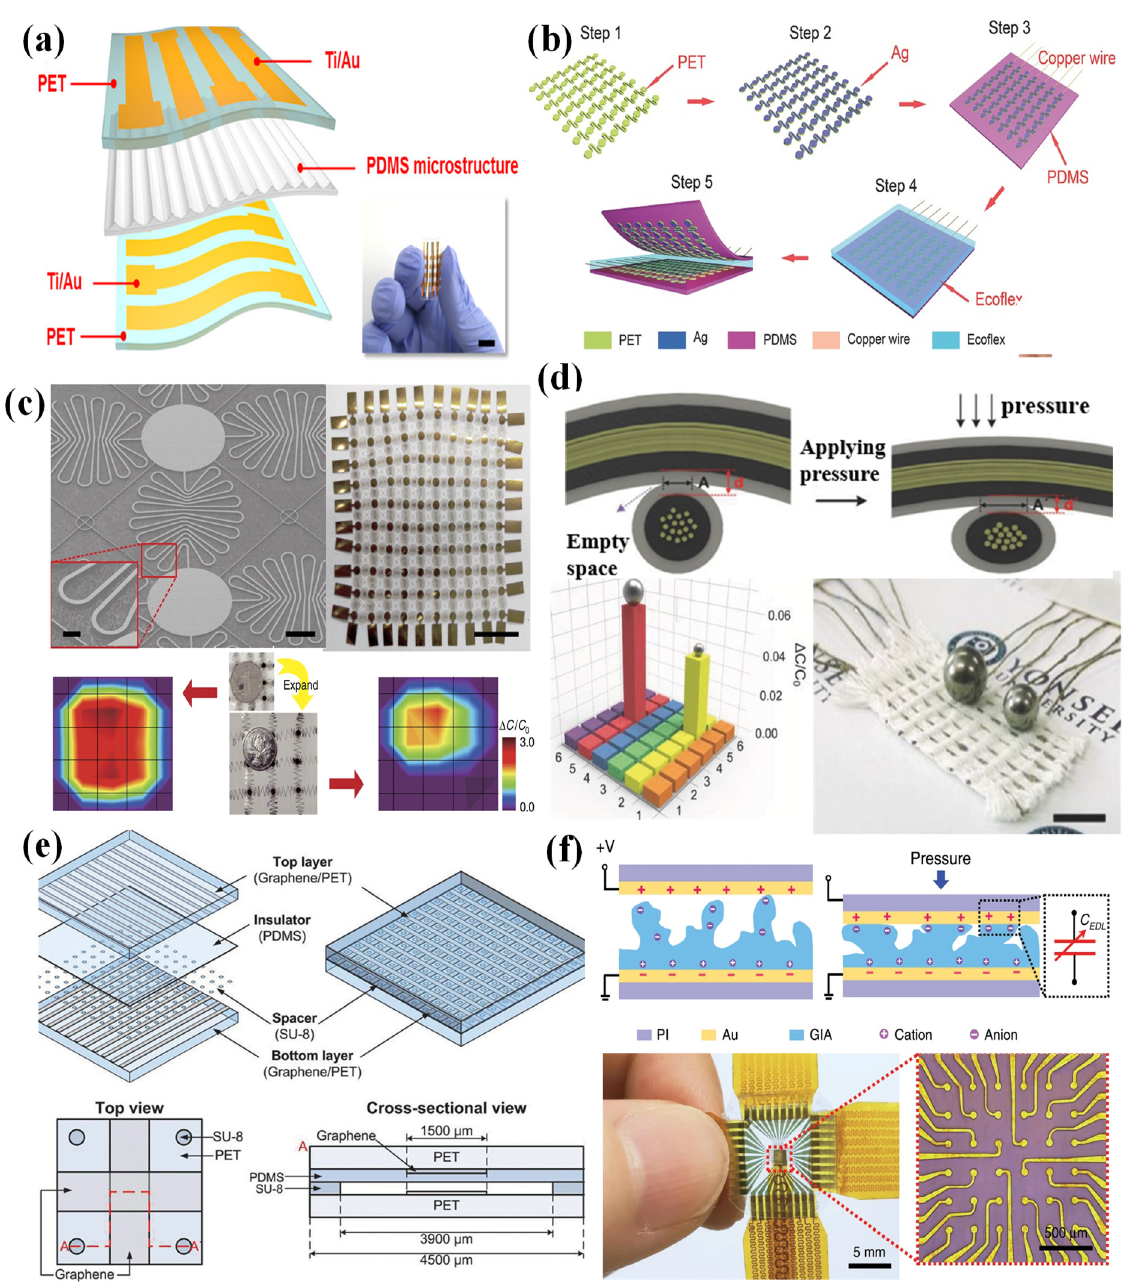
Figure 2. ( a ) A tunable, ultrasensitive, and flexible pressure sensor array based on wrinkled microstructures. Reproduced with permission from Ref. [71]. Copyright 2019, American Chemical Society. ( b ) A flexible, stretchable, and wearable multifunctional sensor array for static and dynamic strain mapping. Reproduced with permission from Ref. [72]. Copyright 2015, WILEY-VCH. ( c ) A skin-inspired highly stretchable and conformable matrix network for multifunctional sensing. Reproduced with permission from Ref. [73]. Copyright 2018, Qilin Hua et al. ( d ) A conductive fiber- based ultrasensitive textile pressure sensor. Reproduced with permission from Ref. [74]. Copyright 2015, WILEY-VCH. ( e ) A flexible, transparent, sensitive, and crosstalk-free capacitive tactile sensor array based on graphene electrodes and air as a dielectric. Reproduced with permission from Ref. [75]. Copyright 2017, WILEY-VCH. ( f ) A graded intrafillable-architecture-based iontronic pressure sensor array with ultra-broad-range high sensitivity. Reproduced with permission from Ref. [76].